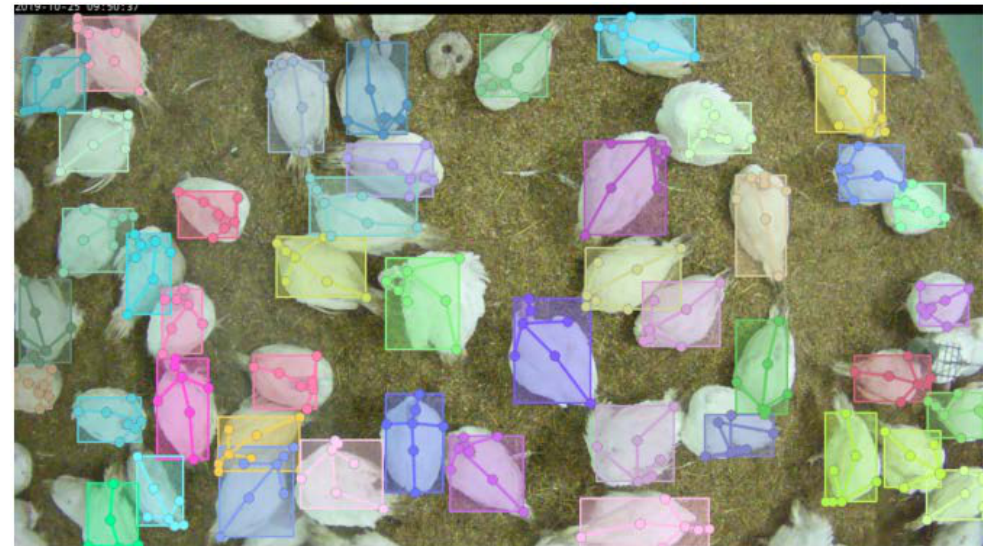
Figure 3. Example image showing the visualization of annotated keypoints and bounding boxes using the COCO API [44].